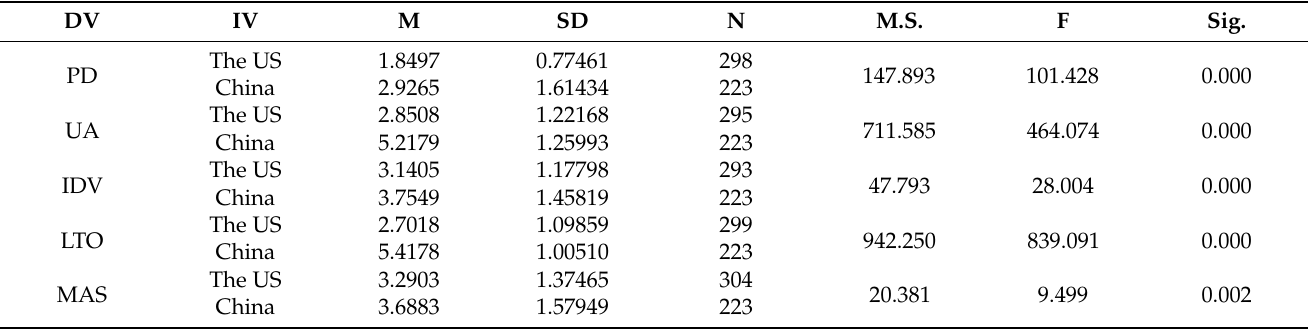
Table 5. Cultural differences between the US and